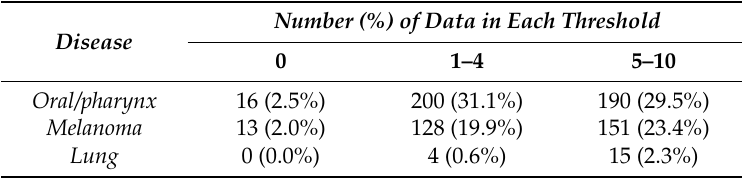
Table 1. Number and percent of zeros and imputed data per